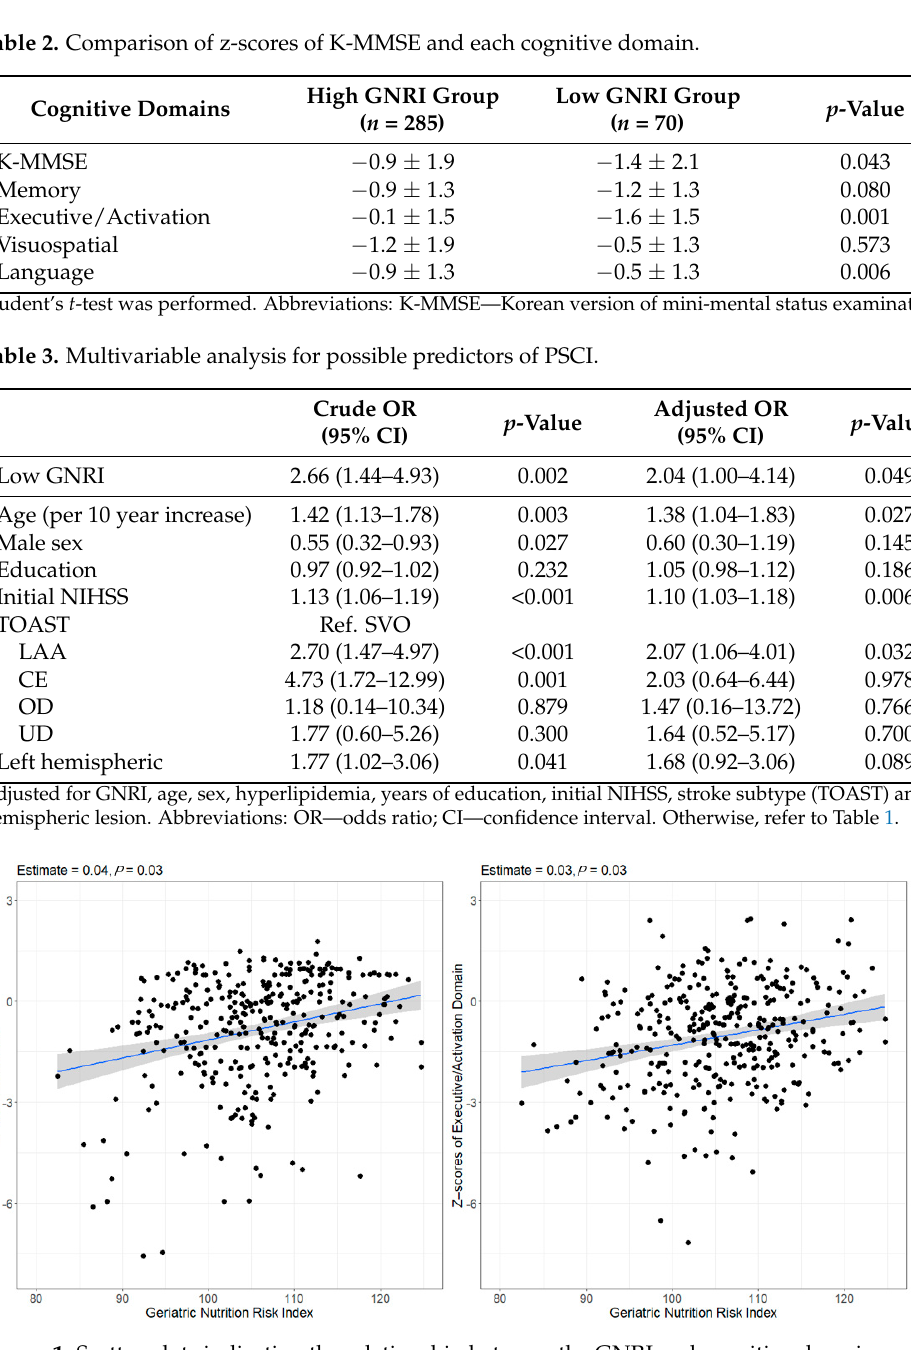
Figure 1. Scatter plots indicating the relationship between the GNRI and cognitive domain z- scores. NRI was significantly associated with the z-scores of the MMSE and the executive/activation domain via multiple linear regression with adjustments for age,